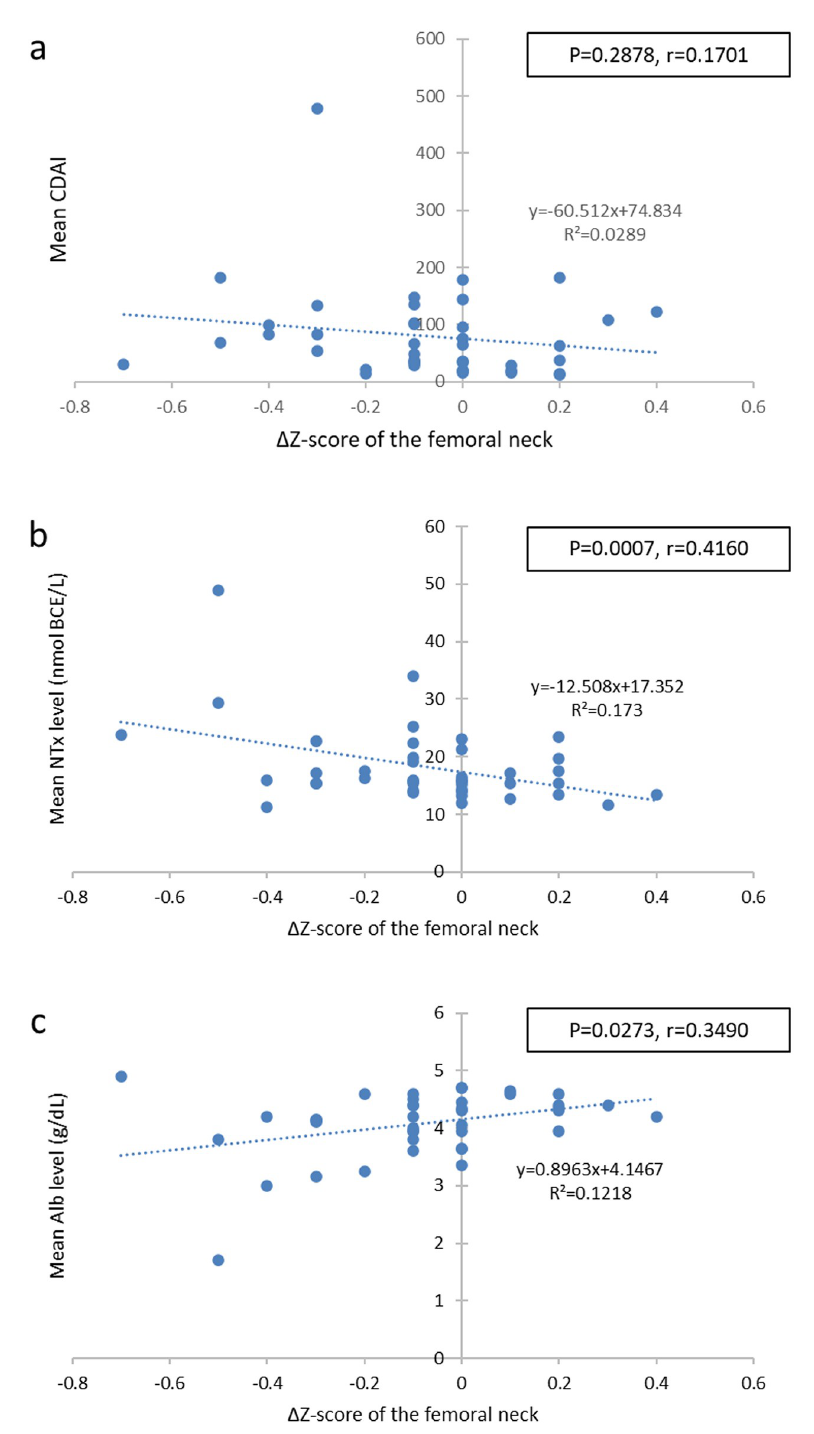
Fig 2. Correlation between the femoral neck Δ Z-score and the mean biomarker levels. Scatter plots of the femoral neck Δ Z-score and the mean CDAI (a), mean NTx (b), and (c) mean Alb. CDAI, Crohn Disease Activity Index; NTx, serum N-terminal telopeptide of type I collagen; Alb, albumin.